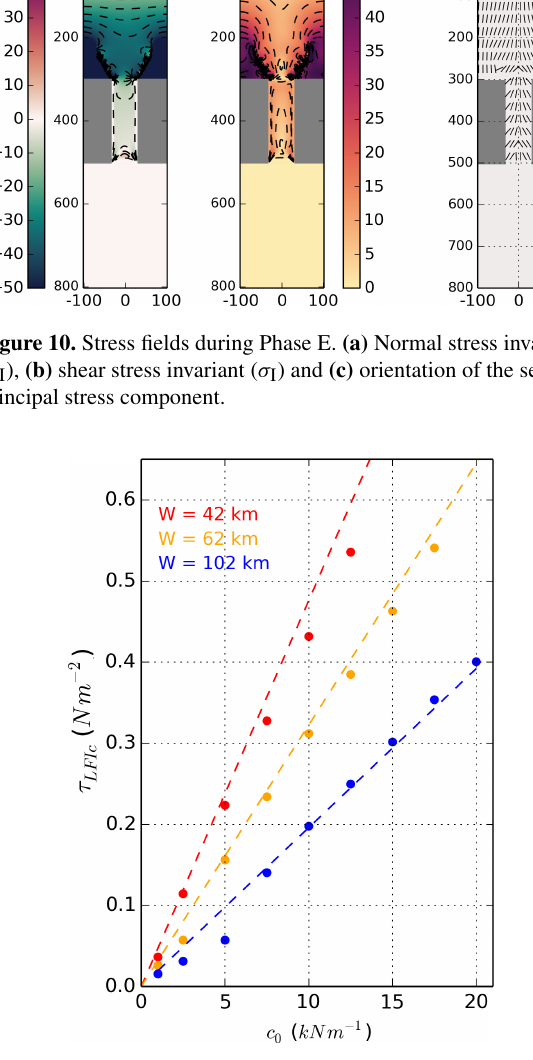
Figure 11. Critical surface forcing associated with the second frac- ture event (Stage D) as a function of cohesion and channel width (dots). Dashed lines indicate the analytic solution from the 1D equa-